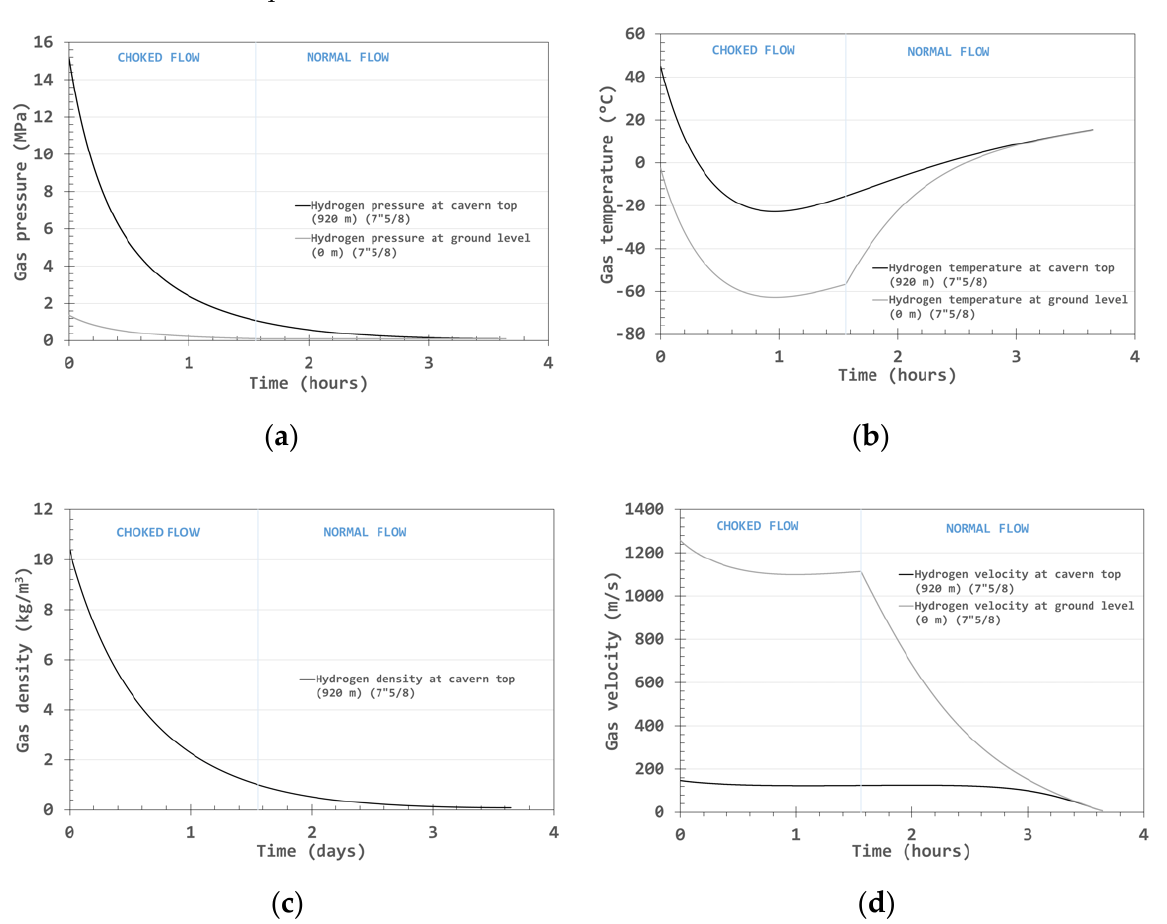
Figure 3. Evolution of: ( a ) hydrogen pressure; ( b ) hydrogen temperature; ( c ) hydrogen density; ( d ) hydrogen velocity, as a function of time.